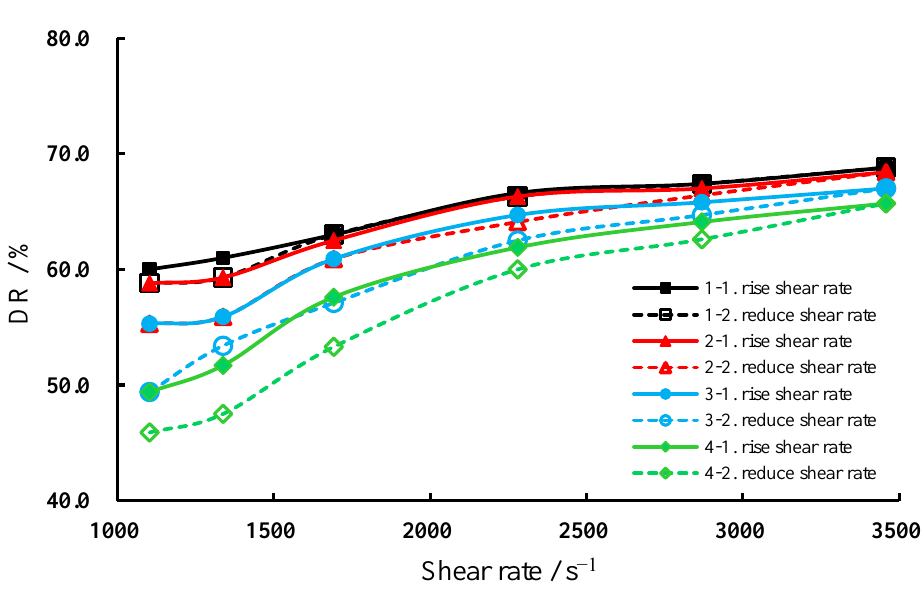
Figure 6. Curves of drag-reduction rate with shear rate (controlled below 3500 s − 1 ).